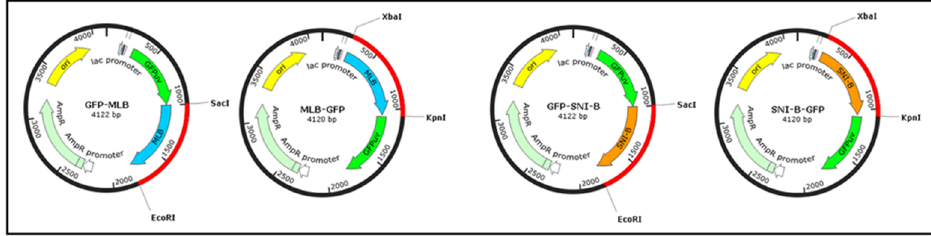
Figure 9. The cloning map of MLB and SNA-B N/C-terminally fused to green florescent protein (GFP) in pGFPuv plasmid. (GFP) in pGFPuv